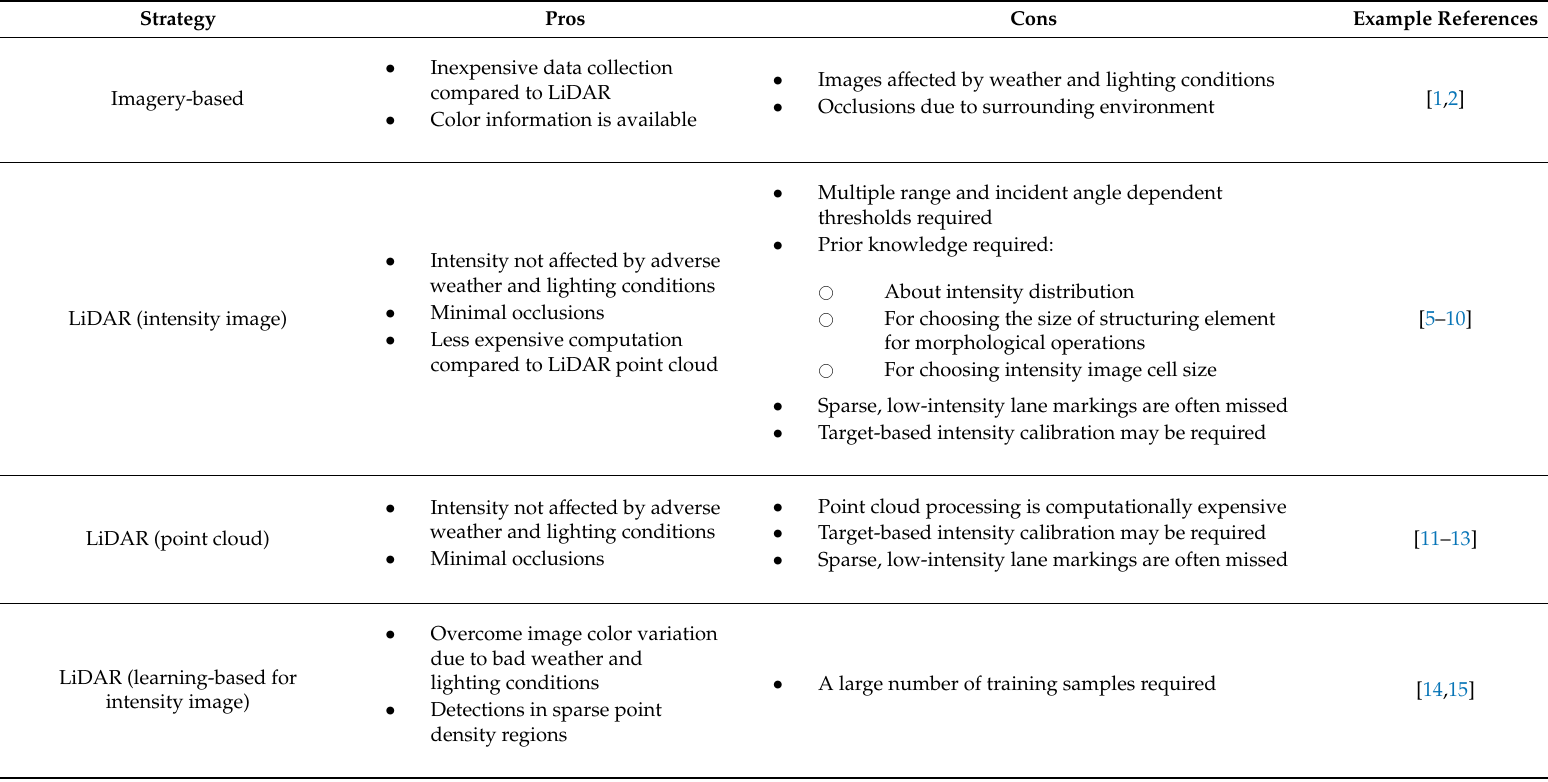
Table 1. Existing lane marking extraction strategies and their advantages and